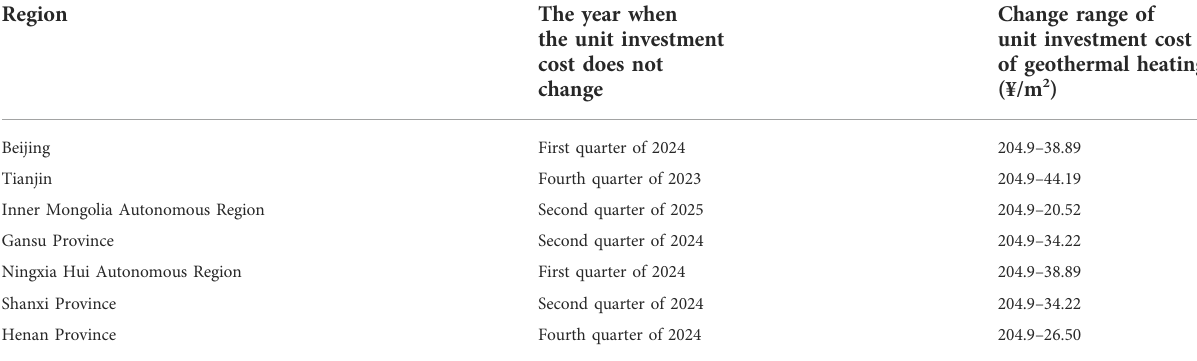
TABLE 5 Variation range of the unit investment cost of geothermal heating in central heating provinces and cities.